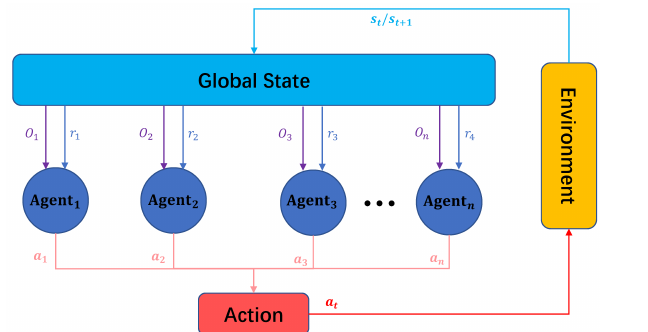
Figure 9. Illustration of the interaction of multiple UGVs under the distributed training and execu- tion strategy.